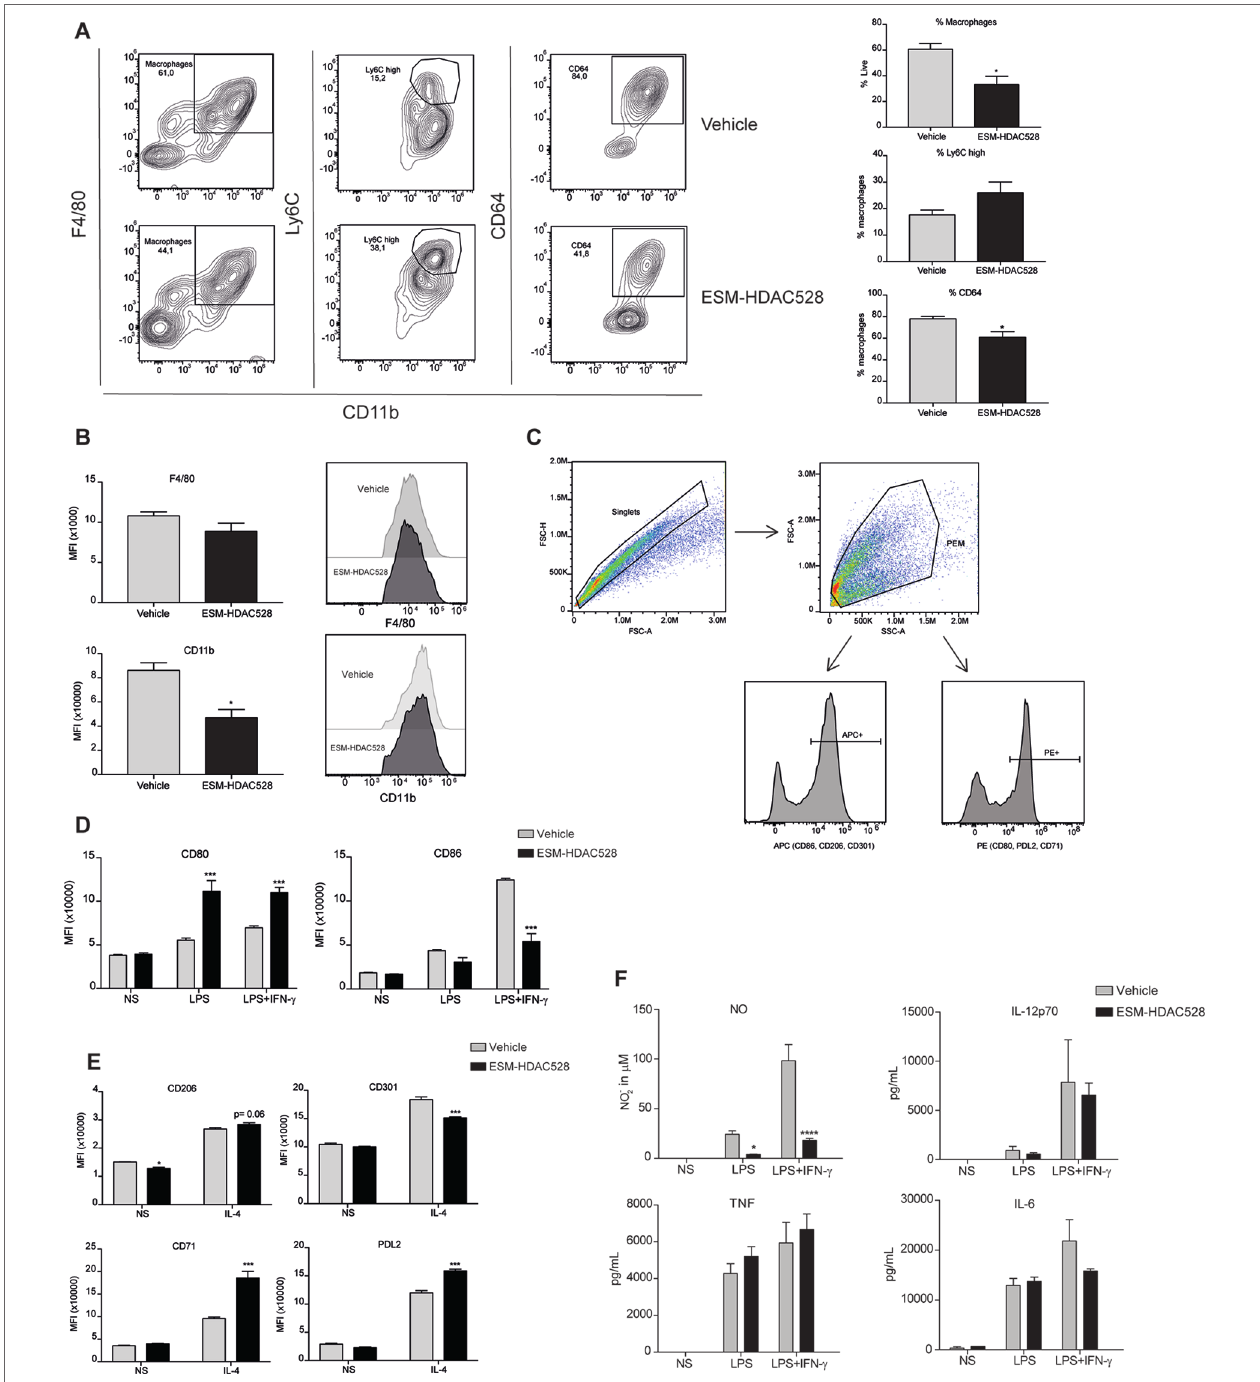
FIGURE 5 | ESM-HDAC528 modulates PEM maturation and activation to a lesser extent in an atherosclerosis model. (A) Percentage of mature (CD11b+ and F4/80+) macrophages from freshly isolated PECs 24 h after ESM-HDAC528 injection and of cells expressing Ly6C and CD64 within this population. n = 5 per group. (B) MFI of F4/80 and CD11b in the mature macrophages 24 h after injection. n = 5 per group. (C) General gating strategy for activation marker expression on PEMs after attachment and 24 h stimulation for activation. Antibodies were conjugated to either APC or PE dependent on the panel. (D) MFI of the positive peaks for pro-inflammatory surface markers in PEMs Isolated, attached and stimulated for 24 h with LPS (10 ng/ml) or LPS (10 ng/ml) + IFN- γ (10 U/ml). n = 5 per group. (E) MFI of the positive peak for alternative activation surface markers in PEMs attached and stimulated for 24 h with IL-4 (20 ng/ml). n = 5 per group. (F) Cytokine production by PEMs isolated from the mice (n = 5) of each group stimulated 24 h with LPS (10ng/ml) or LPS (10ng/ml) + IFN- γ (10 U/ml). Statistical significance was determined by unpaired t -test (A and B) or two-way ANOVA with Bonferroni correction (D – F) (p < 0.05). All error bars represent the SEM. ns = p value > 0.05, * p value ≤ 0.05, ** p value ≤ 0.01, *** p value ≤